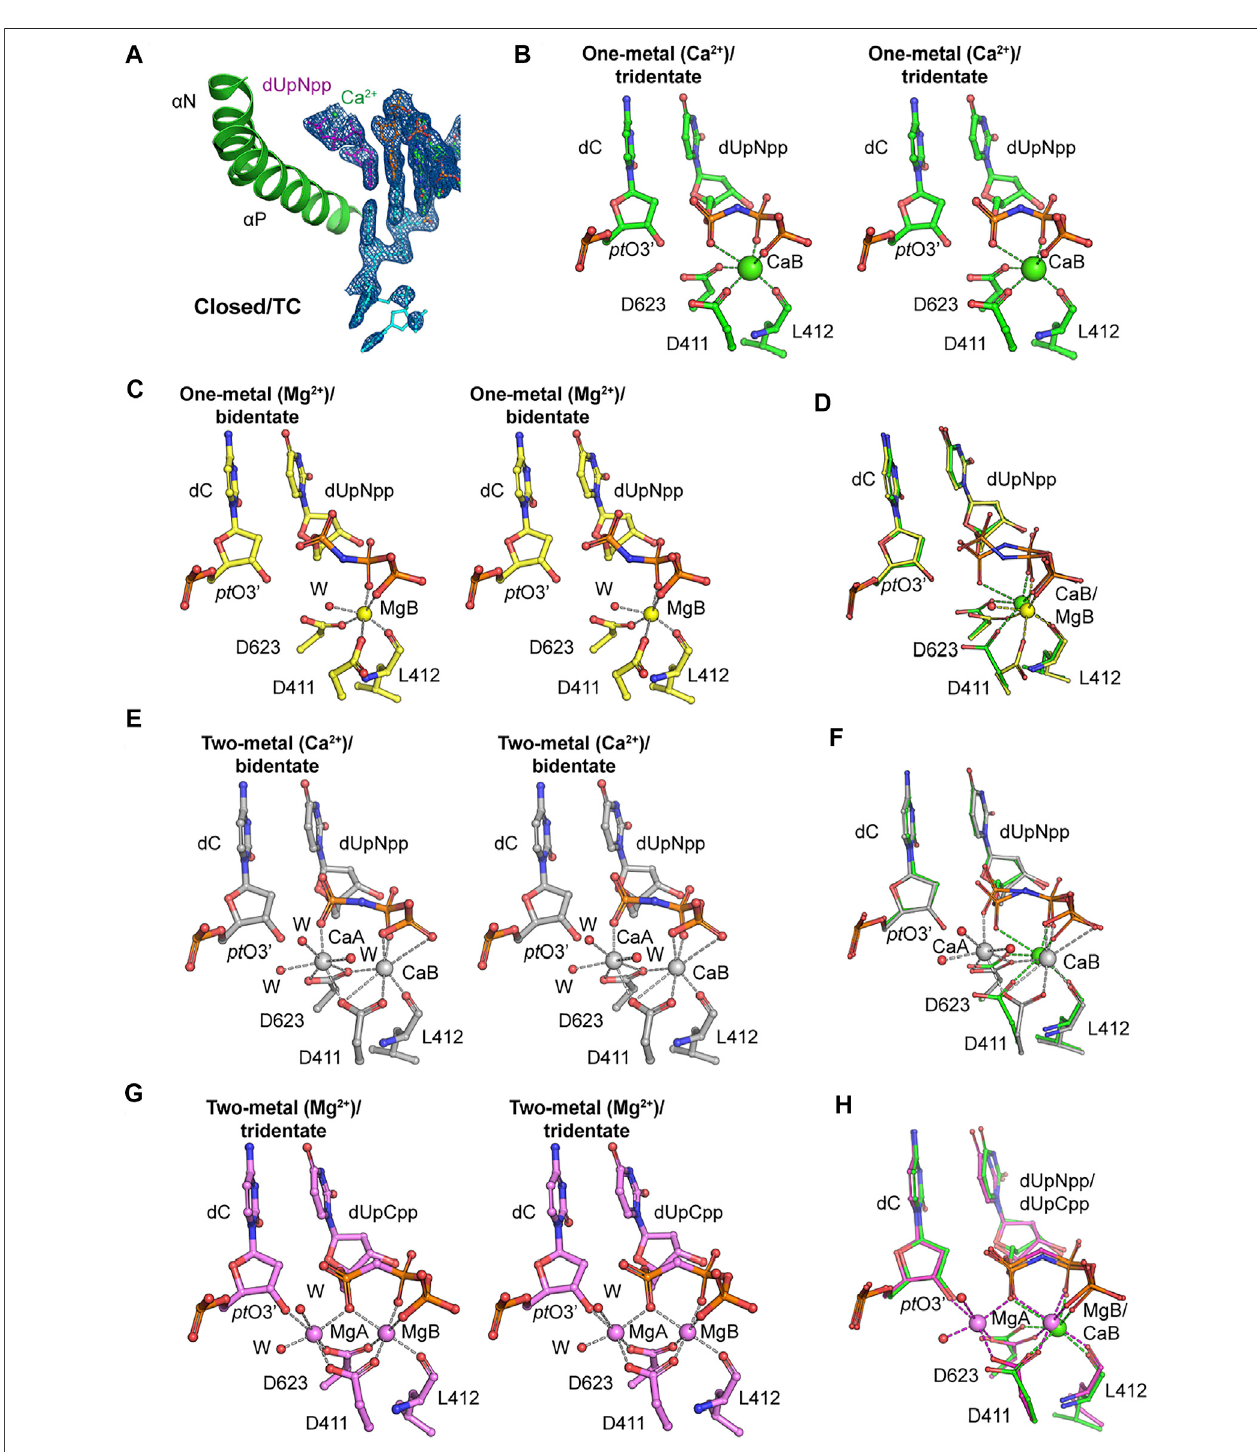
FIGURE 2 | Metal coordination in the closed ternary complexes. (A) Closed ternary complex (MolA) containing one divalent metal ion bound to the triphosphate moietyinstead ofthetwo observed previously. IncomingdNTP (dUpNpp),primer, and template are inmagenta,orange, and cyan, respectively. The σ A -weighted 2 F obs - F calc electron density maps are contoured at 1.5 σ . (B) Stereodiagram of tridentate Ca 2+ coordination in the one – metal ion replication complex (MolA) with octahedral geometry. The Ca 2+ ion is in green, and Ca 2+ coordination is marked with dashed lines. (C) Stereodiagram of bidentate Mg 2+ coordination in the one – metal ion replication complex (PDB ID 3si6) with octahedral geometry. The Mg 2+ ion is in yellow, and Mg 2+ coordination is marked with dashed lines. (D) Superimposed representation of Ca 2+ or Mg 2+ coordination complexes of the one – metal ion with tridentate coordination (MolA, green) and with bidentate coordination (yellow). The